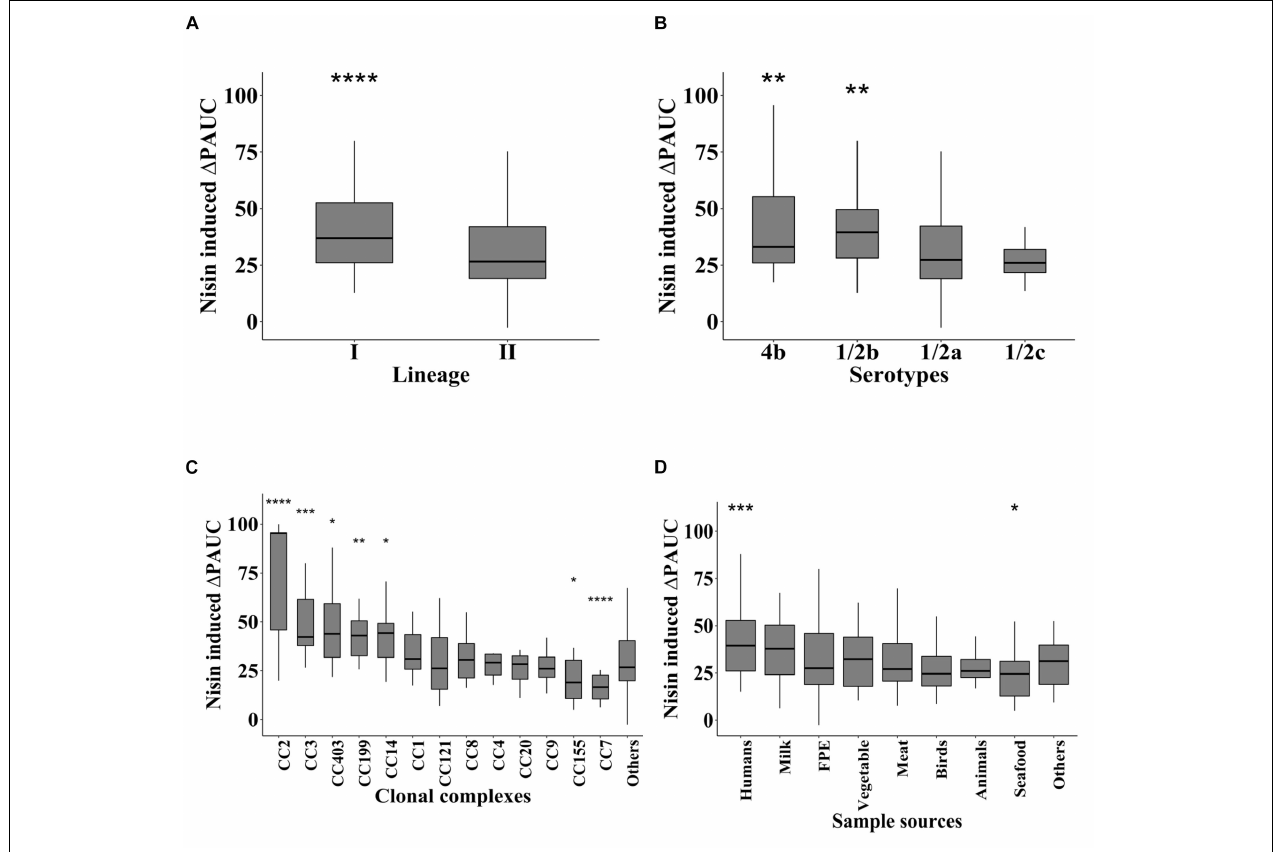
FIGURE 2 | Nisin resistance variation is associated with L. monocytogenes molecular subtypes and isolation sources. Nisin inhibition induced (cid:49) PAUC comparisons between L. monocytogenes strains grouped according to (A) genetic lineage, (B) serotype and (C) MLST CC and (D) isolation sources. Significant differences between the groups identified using one-way ANOVA and Tukey post hoc test pairwise comparison of the different groups. ∗ P < 0.05; ** P < 0.01, *** P < 0.001, **** P <